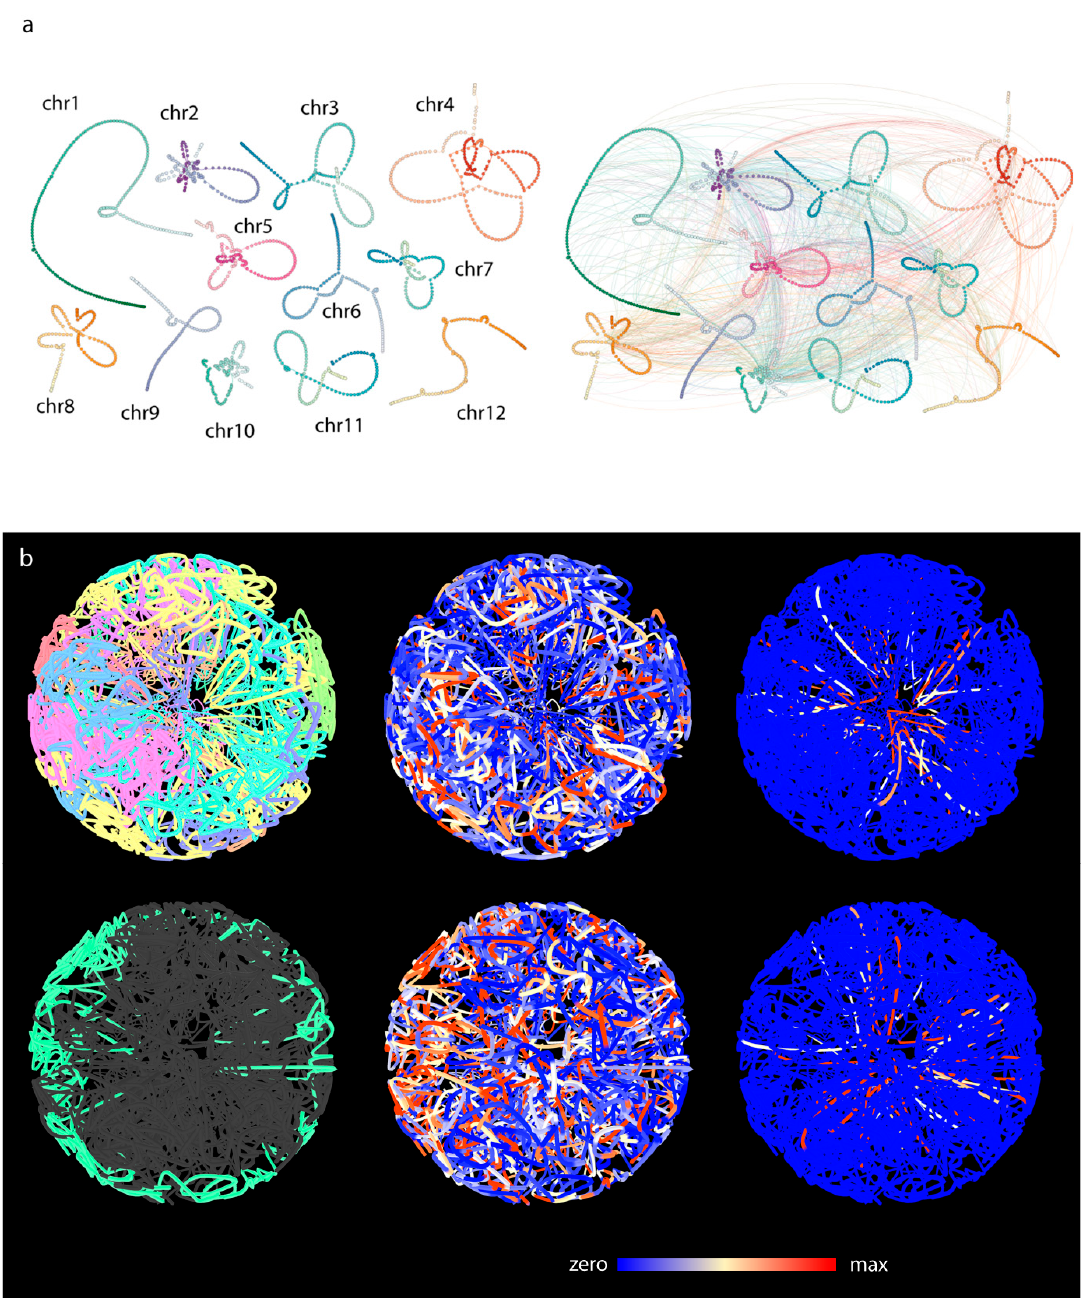
Figure 7. Rice sc Hi-C data-based genome graph construction. ( a ) The 2D multigraph image of rice sperm cell. Left without interchromosomal contacts, right interchromosomal contacts drawn. ( b ) Three-dimensional pseudo-structure of rice sperm cell. The two rows represent two orthogonal perspectives of the pseudo-structure. Coloring is based on different attributes. Chromosome